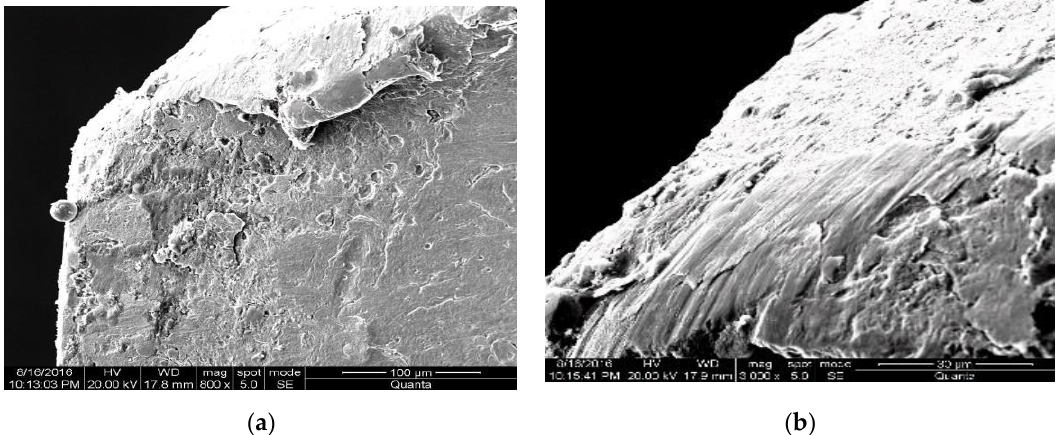
Figure 2. Micro-fracture morphology of the crack source and the fatigue striations: ( a ) 800×; ( b ) 3000×.